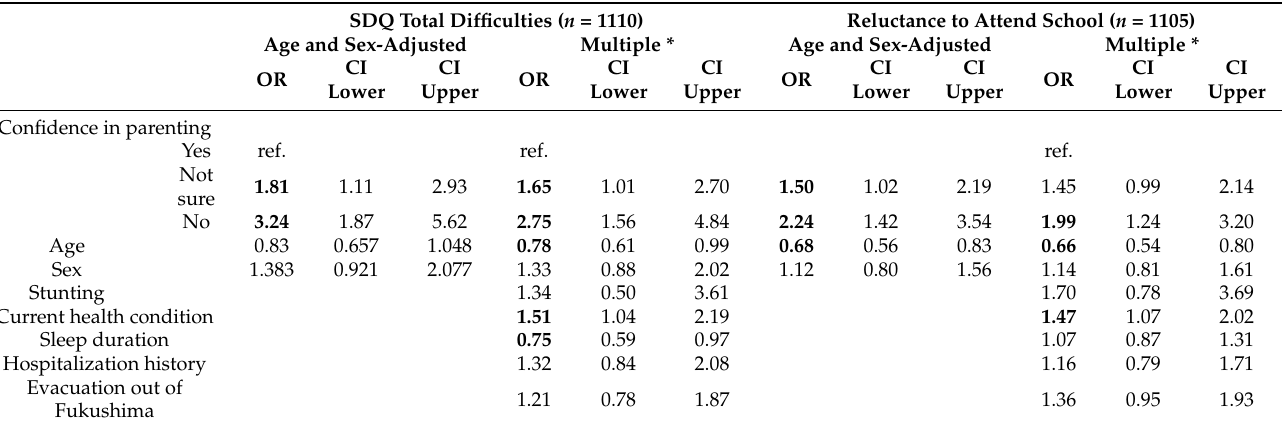
Confidence in parenting